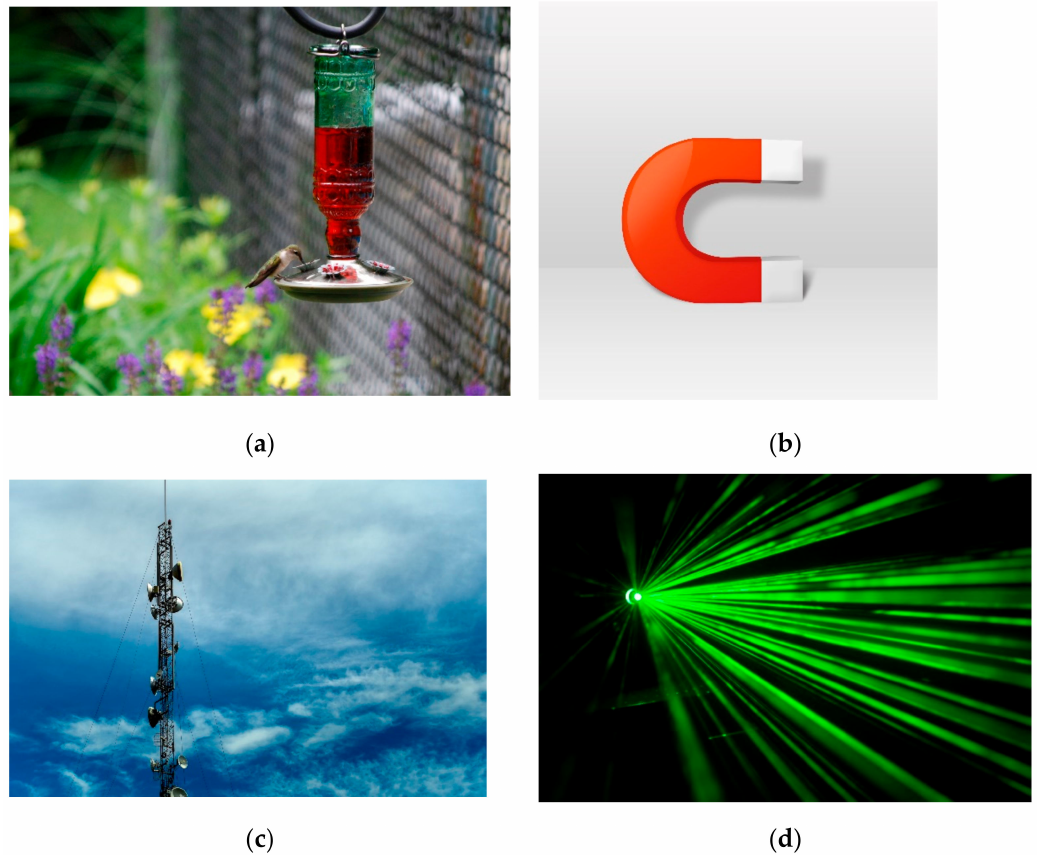
Figure 7. Other techniques: ( a ) lure area; ( b ) magnets; ( c ) microwaves; ( d )